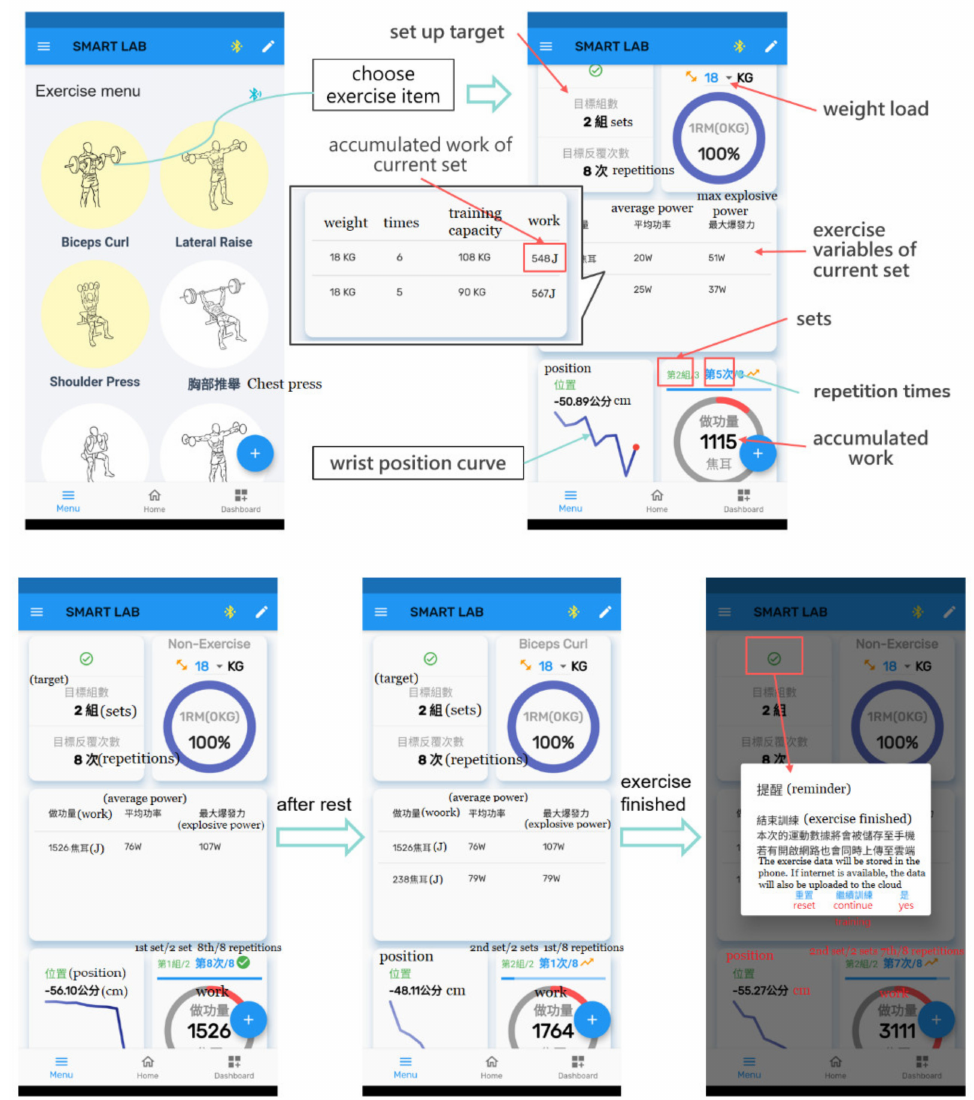
Figure 13. The exercise menu the user can choose and the API indicating wrist position curve, repetitions, accumulated work, exercise variables of each set,